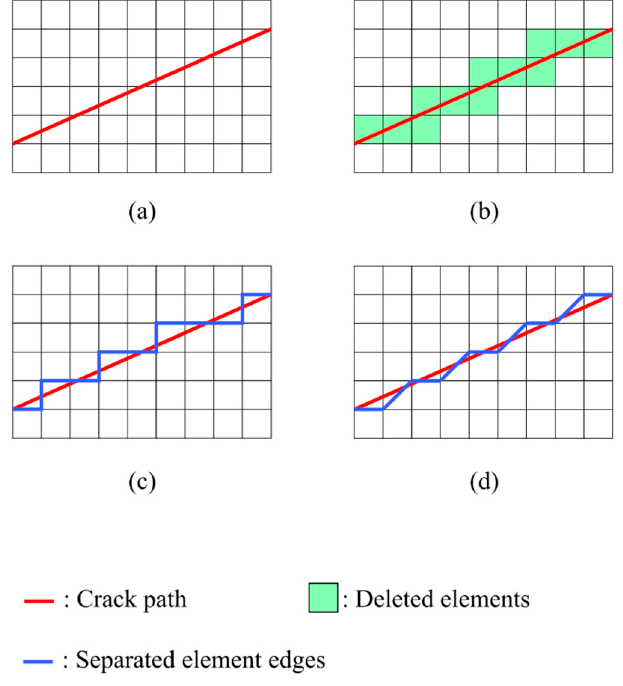
Figure 1. ( a ) The original mesh and the crack path; ( b ) Crack representation using the element deletion method; ( c ) Crack representation using the edge separation method; ( d ) Crack representation using the element splitting method.